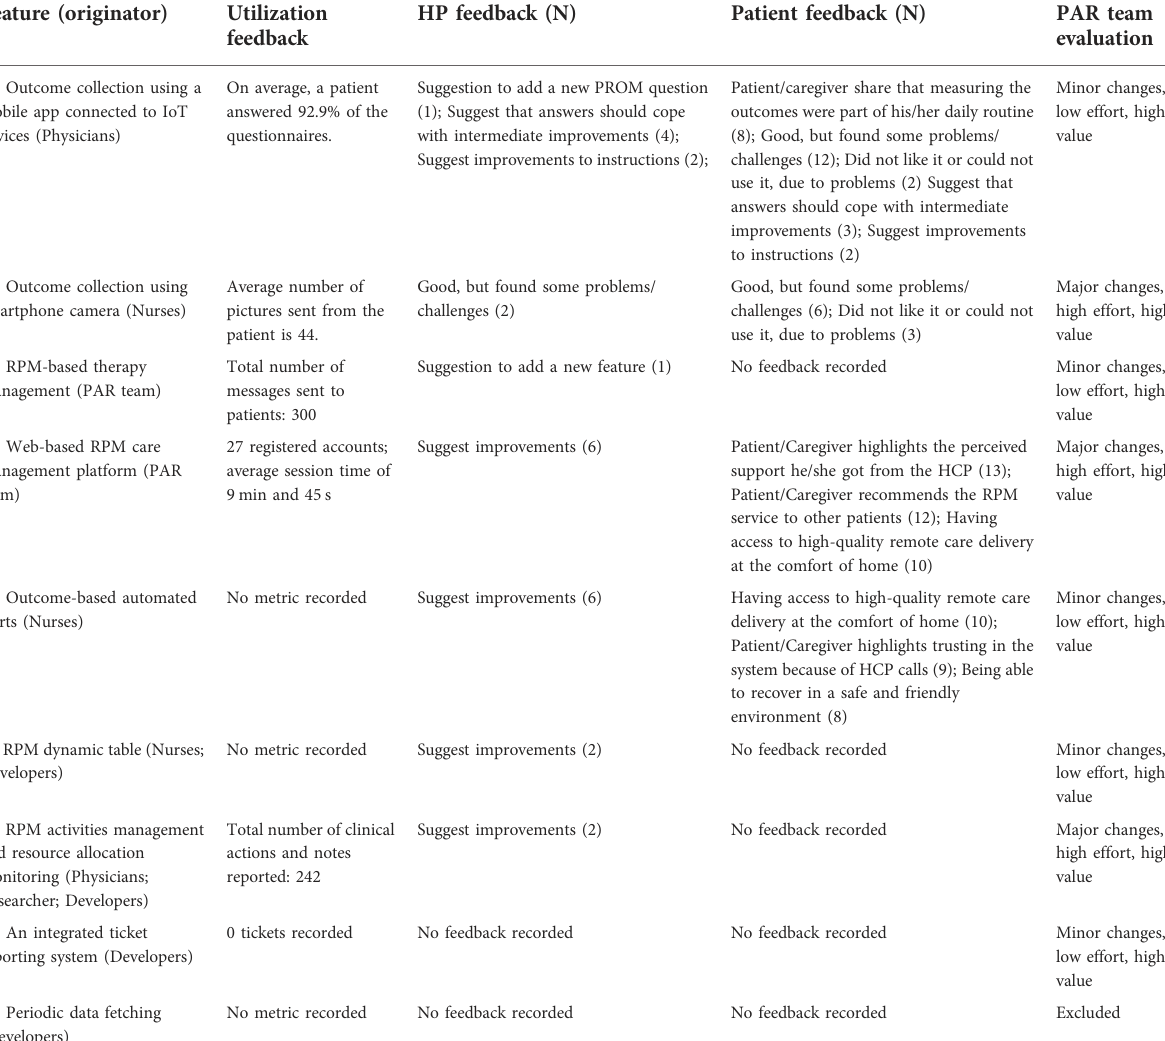
TABLE 3 List of features of pilot initiative